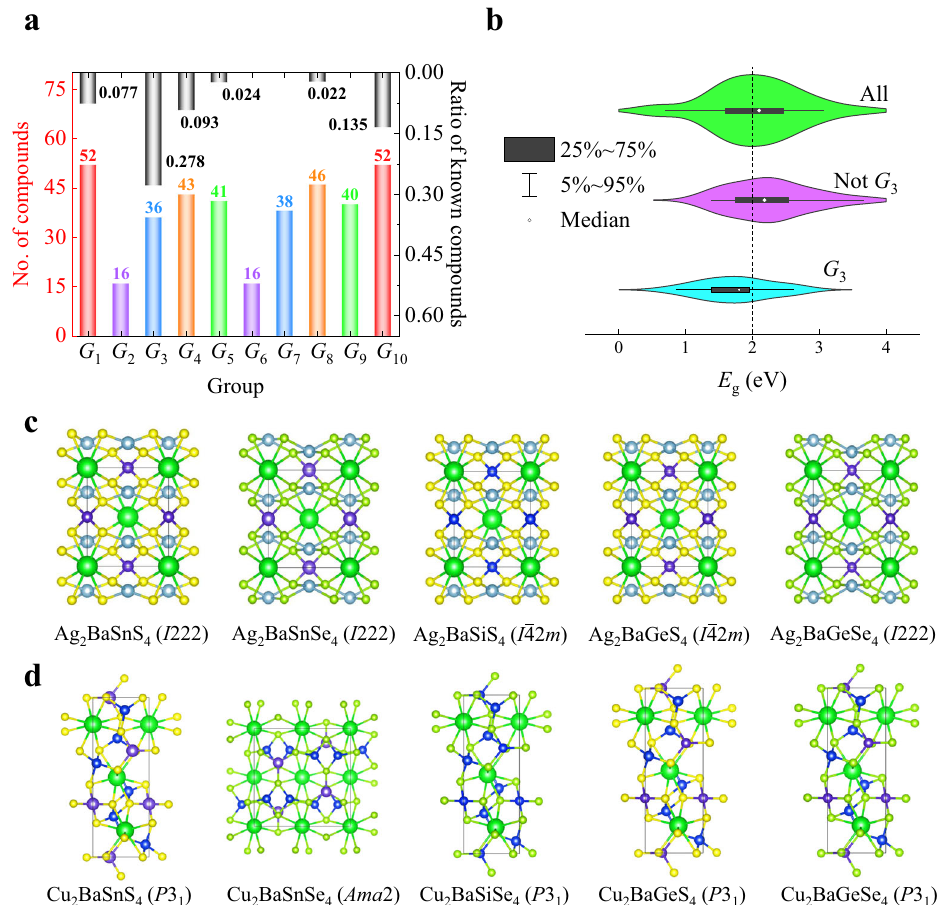
Fig. 3 Further analysis of group partitioning by unsupervised learning. a A statistical graph of the number of compounds in each group (left), and the ratio of known compounds in each group (right). b Violin plots of E g of 27 known compounds, ten known compounds in G 3 , and other 17 known compounds not clustered in G 3 . The outer shells of the violins bound all data, narrow horizontal lines bound 90% of the data, thick horizontal lines bound 50% of the data, and white dots represent medians. The dashed line shows the position of E g = 2.0 eV. c Five known I 2 -II-IV-X 4 semiconductors in G 3 , where I = Ag + . d Five known I 2 -II-IV-X 4 semiconductors in G 3 , where I = Cu +